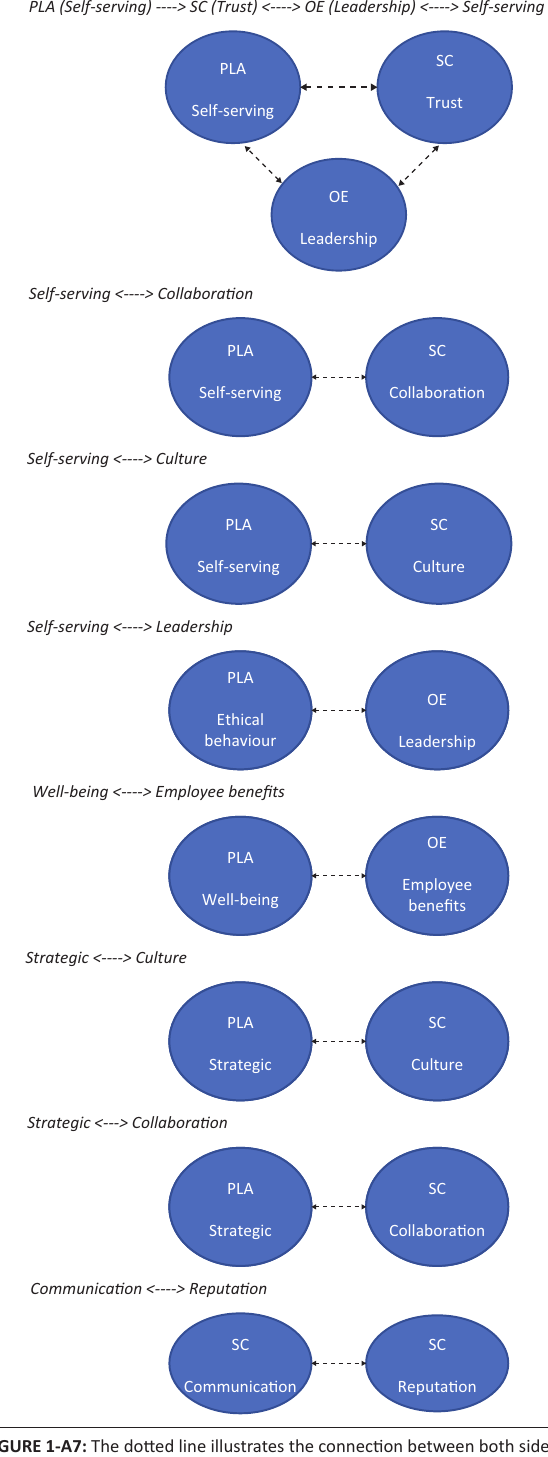
FIGURE 1-A7: The dotted line illustrates the connection between both sides. PLA, perceived leadership attributes; SC, social capital; OE, organisational effectiveness.